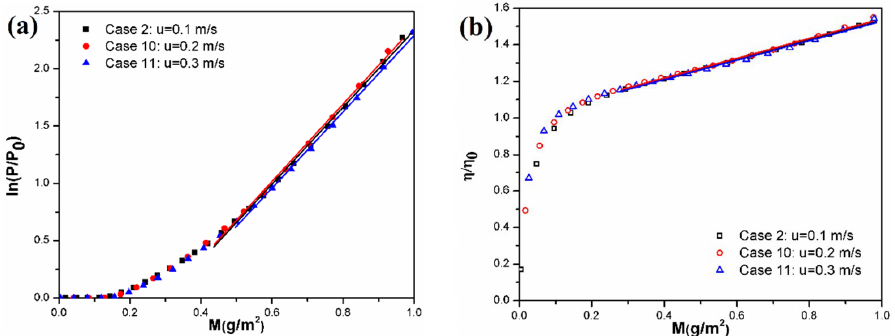
Figure 14. ( a ) Logarithmic scaling of the normalized pressure drop and ( b ) dynamic changes in normalized capture efficiency with different inlet fluid velocities.